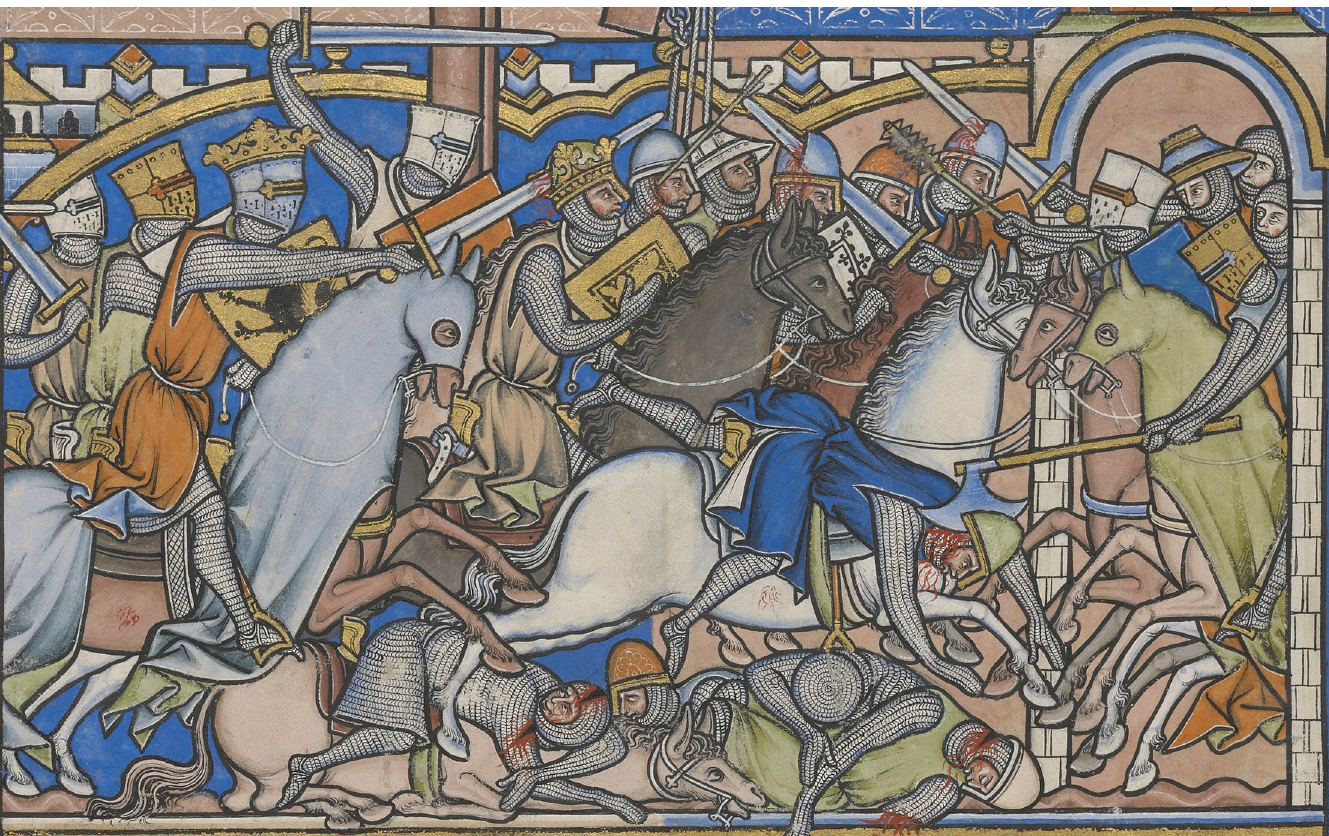
Fig 7. Detail from the Maciejowski Bible, produced in France 1244–1254. Whilst presenting Biblical scenes, these are depicted in the style, social context and material culture of 13th century France and so are a useful source regarding battle injuries and the weapons used by French troops at the time of the raid on Sidon. (Image: